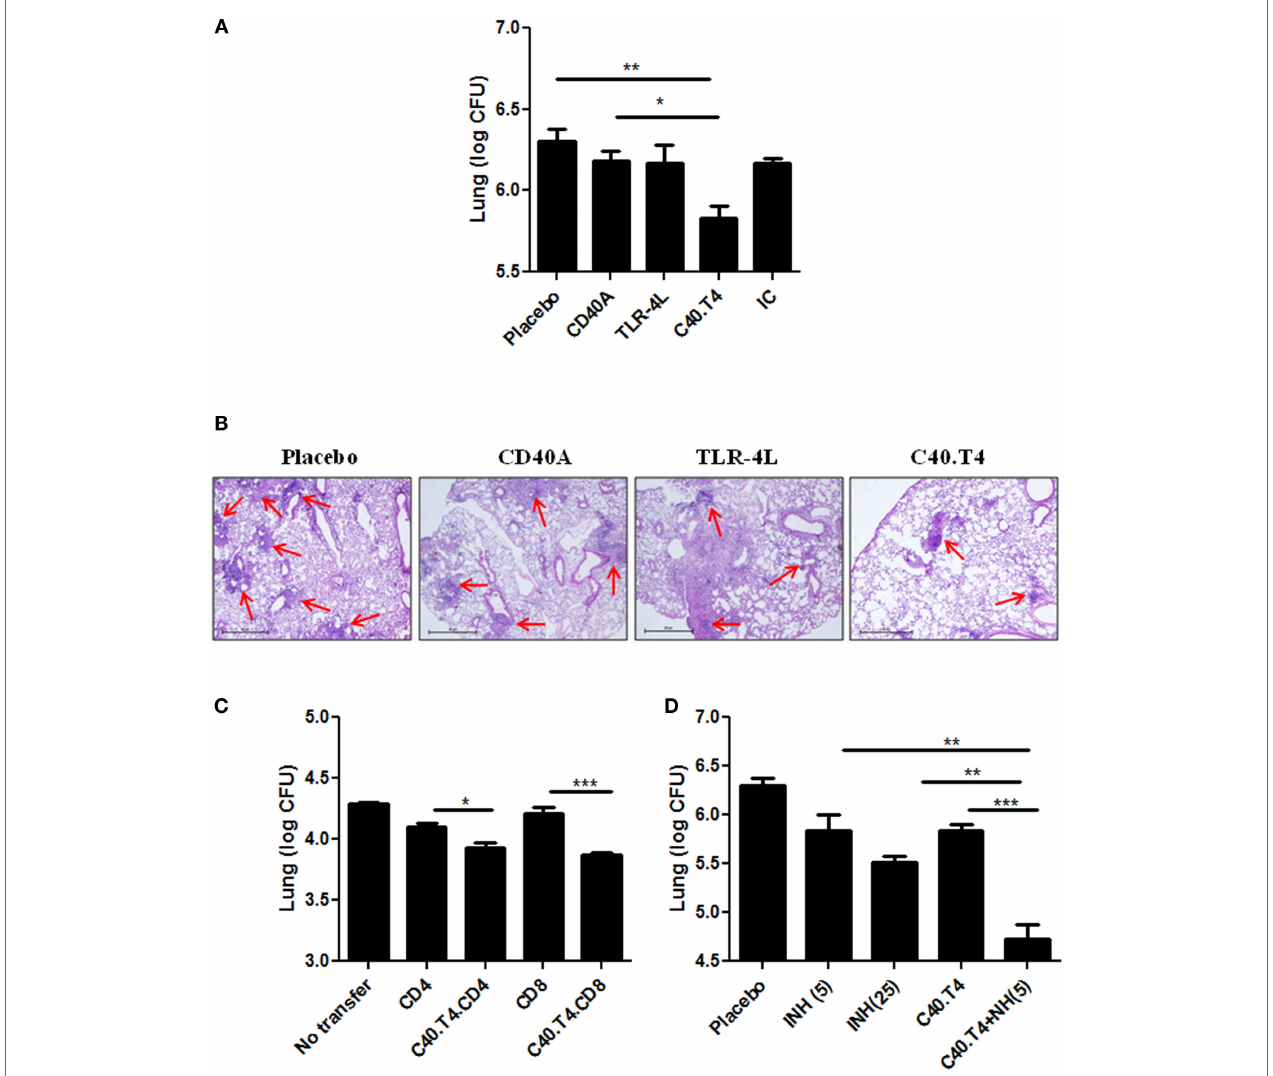
FigUre 8 | immunomodulation through c40.T4 reduces the bacterial burden in the lungs of Mtb -challenged mice and enhances the potency of isoniazid . (a) Mice infected with Mtb were immunized with C40.T4. Later, animals were sacrificed and mycobacterial load in the lungs was enumerated by CFUs plating; (B) Photomicrographs (40 × ) of H & E stained lung sections. (c) CD4 and CD8 T cells were purified from C40.T4 treated and Mtb -challenged mice. Later, CD4 or CD8 T cells were adoptively transferred into sub-lethally irradiated mice. After 12 h, mice were aerosol challenged with Mtb . The bacterial burden in the lungs was enumerated on 15 days by CFUs plating. Labeling of “ x ” axis signifies CD4 or CD8: adoptive transfer of either CD4 or CD8 T cells isolated from Mtb -challenged mice; C40.T4.CD4 or C40.T4.CD8: adoptive transfer of either CD4 or CD8 T cells isolated from Mtb -challenged and C40.T4-treated mice. (D) Animals infected with Mtb were administered with C40.T4 and two doses of INH (INH5: 5 mg/kg bwt, INH25: 25 mg/kg bwt of mouse). Later, mice were sacrificed and mycobacterial load was enumerated in the lungs by CFUs plating. Data represented as mean ± SEM are from two independent experiments with ( n = 4mice/group). Control groups of mice were administered PBS, CD40A, TLR-4L. “IC”: isotype control. “*,” “**,” and “***” indicate p < 0.05, p < 0.01, and p < 0.001,